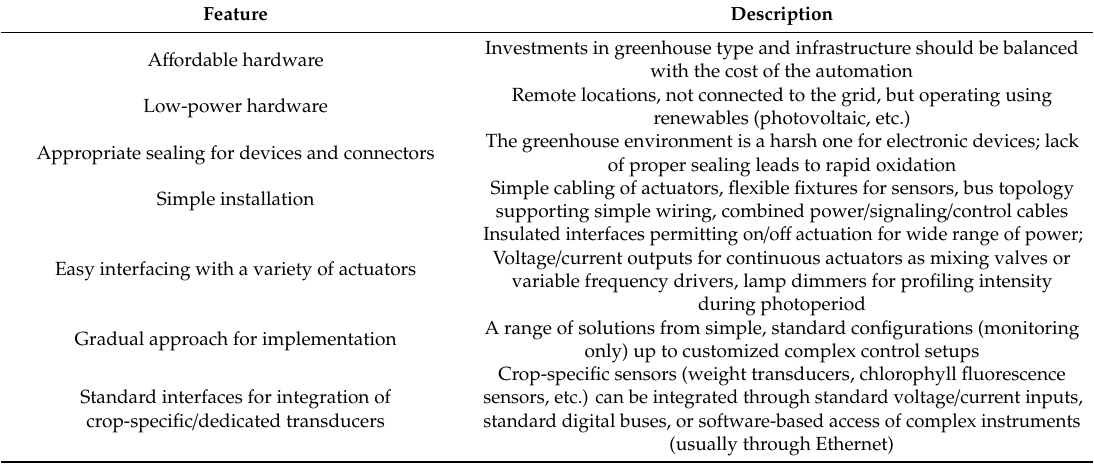
Table 1. Challenges for automatic control systems (ACSs) used in agricultural